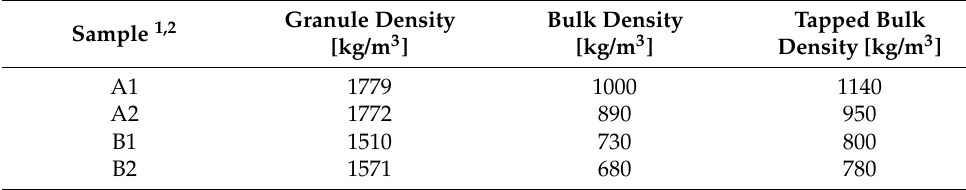
Table 1. Density of the used and obtained material. Sample